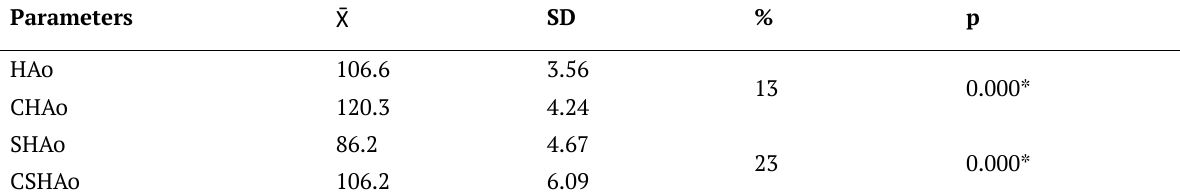
Table 4. Differences between natural angle degrees and clinical angle degrees that occur during cycling Parameters X̄ SD % p HAo 106.6 120.3 SHAo 86.2 106.2